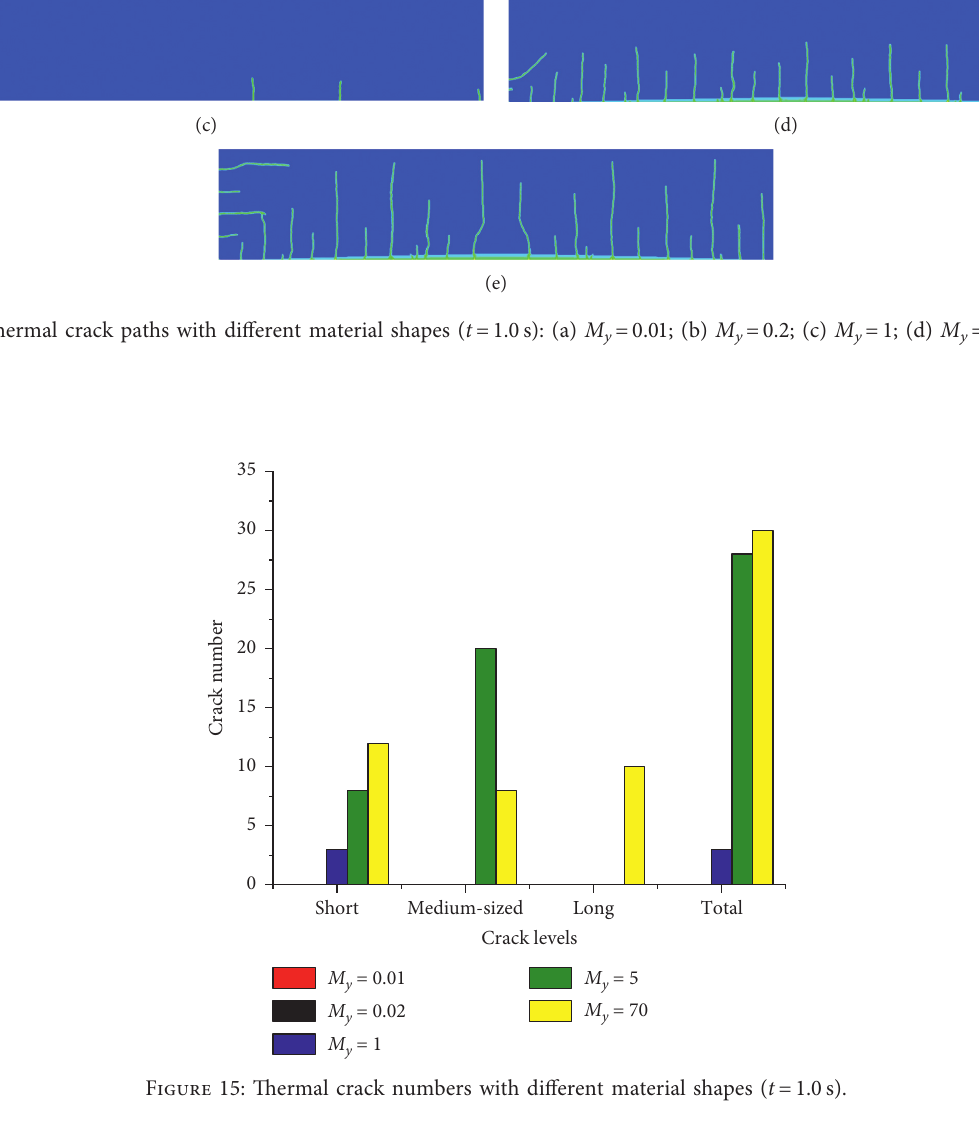
Figure 15: Thermal crack numbers with different material shapes ( t � 1.0